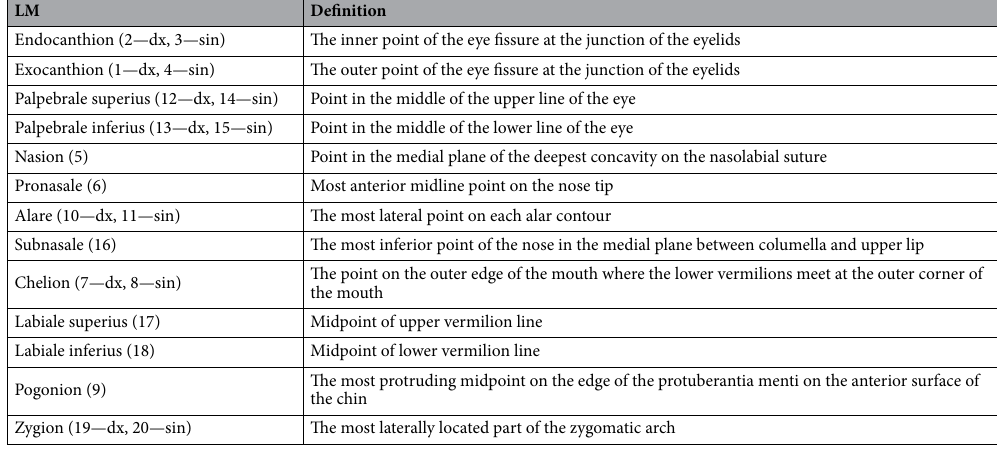
Table 2. Definition of the landmarks used in the